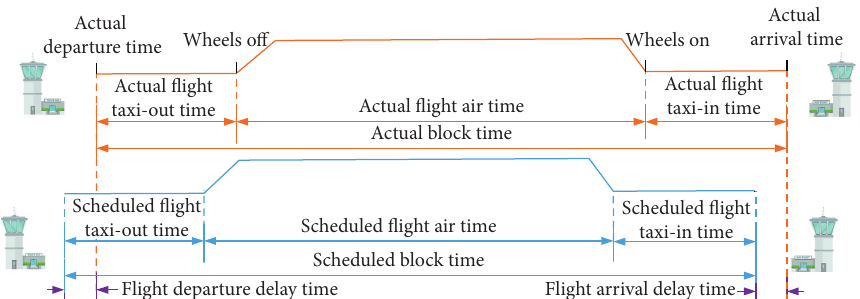
Figure 1: SBT and flight block time